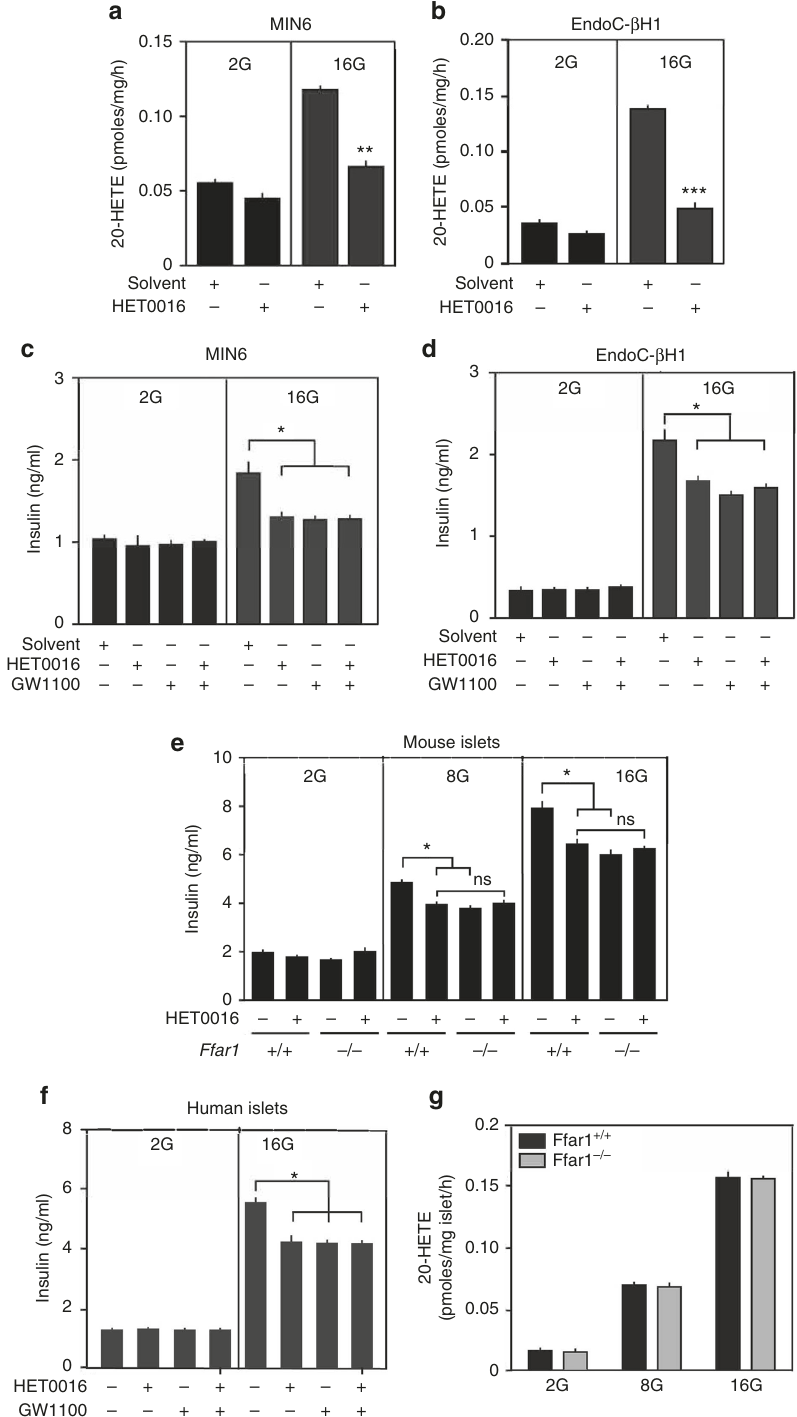
Fig. 4 FFAR1 and 20-HETE contribute to GSIS. a , b Effect of HET0016 on glucose induced release of 20-HETE from MIN6 ( a ) and EndoC- β H1 cells ( b ). c , d Effect of HET0016 (30 µ M) and GW1100 (30 µ M) on insulin secretion from MIN6 ( c ) and EndoC- β H1 cells ( d ) kept in 2.8 (2G) and 16.7 mM (16G) of glucose. e Effect of HET0016 (30 µ M) on insulin secretion from wild-type ( Ffar1 +/+ ) and Ffar1-de fi cient ( Ffar1 − / − ) islets kept in 2.8 (2G), 8.35 (8G), and 16.7 mM (16G) of glucose. f Effect of HET0016 (30 µ M) and GW1100 (30 µ M) on insulin secretion from human islets kept in 2.8 (2G) and 16.7 mM (16G) of glucose. g Glucose-stimulated 20-HETE release from wild-type ( Ffar1 +/+ ) and Ffar1-de fi cient ( Ffar1 − / − ) islets. Shown are mean values ± s.e.m., n = 6 ( a – d ), n = 9 ( e , f ), n = 3 ( g ); * P ≤ 0.05; ** P ≤ 0.01; *** P ≤ 0.001 (Student ’ s two-tailed t